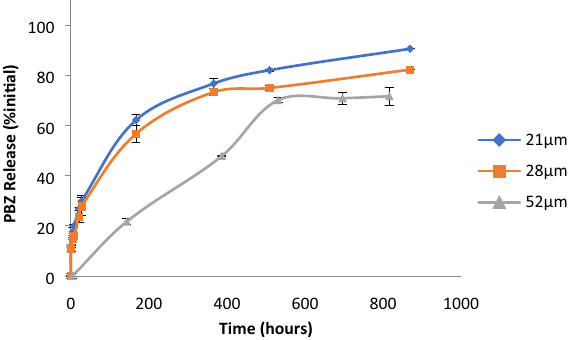
Figure 7. Effect of PCL microbeads size embedded in alginate beads on release of AI from alginate beads.